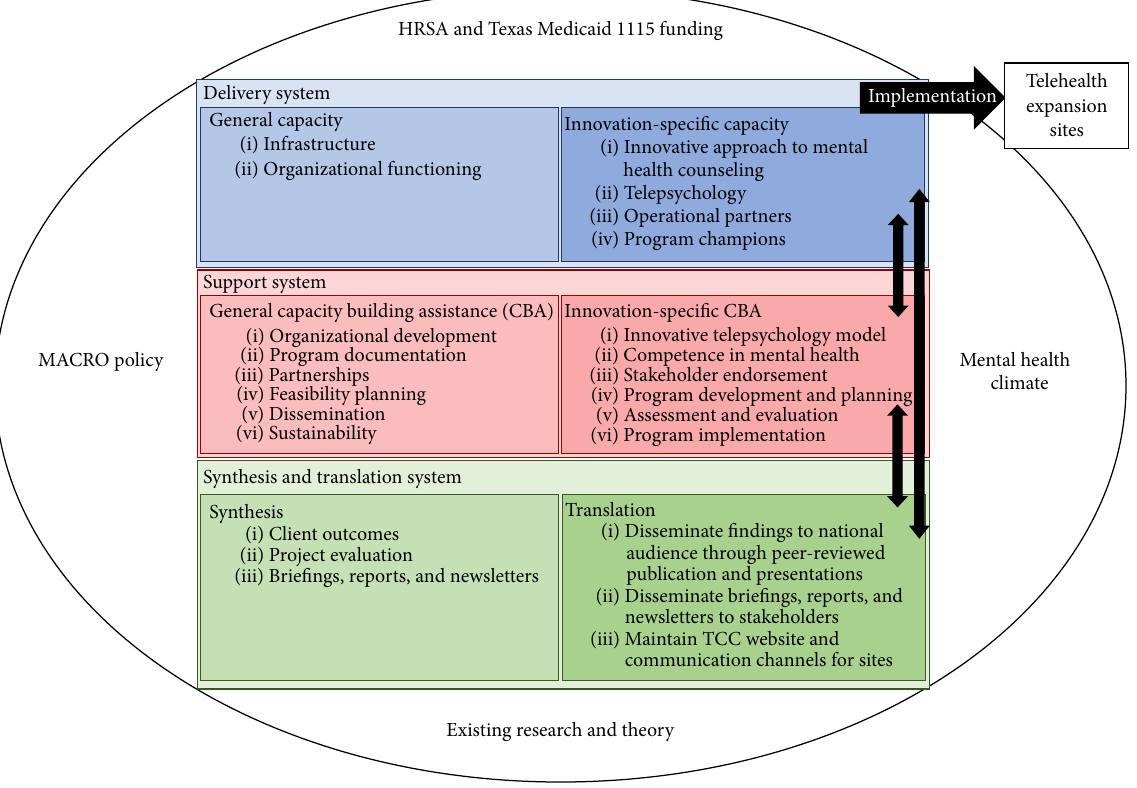
Figure 1: Interactive system framework